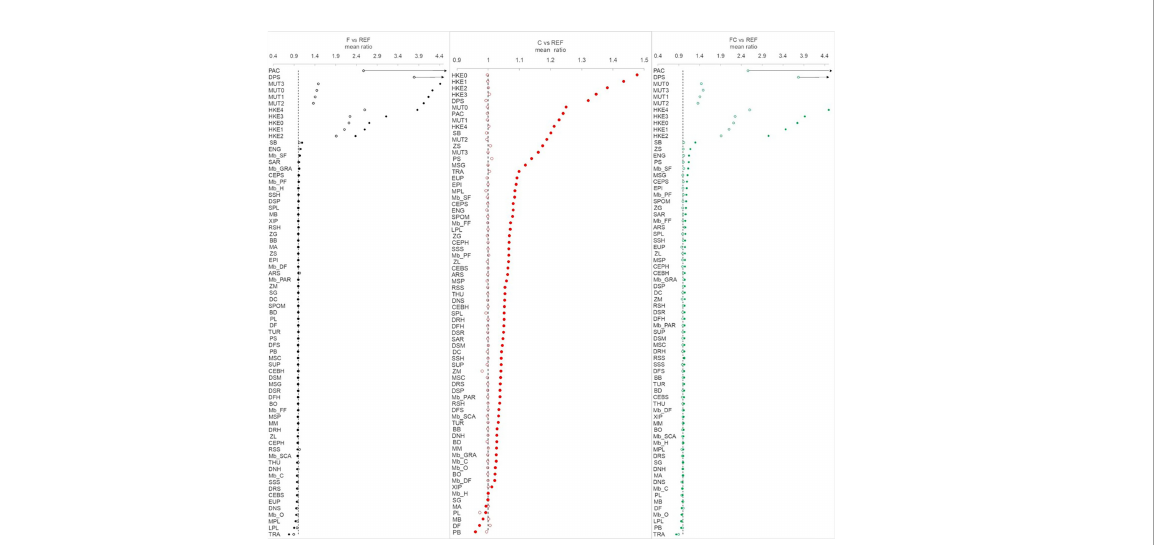
FIGURE 3 Mean ratio of biomass calculated for each functional group by comparing alternative scenarios (F, C, FC) with the reference (REF, y=1, dotted black line) across the years 2026-2030 (open circle) and 2046-2050 (solid circle). Ending values of PAC and DPS in F and FC scenario are outside of the scale (values reported in the main text).